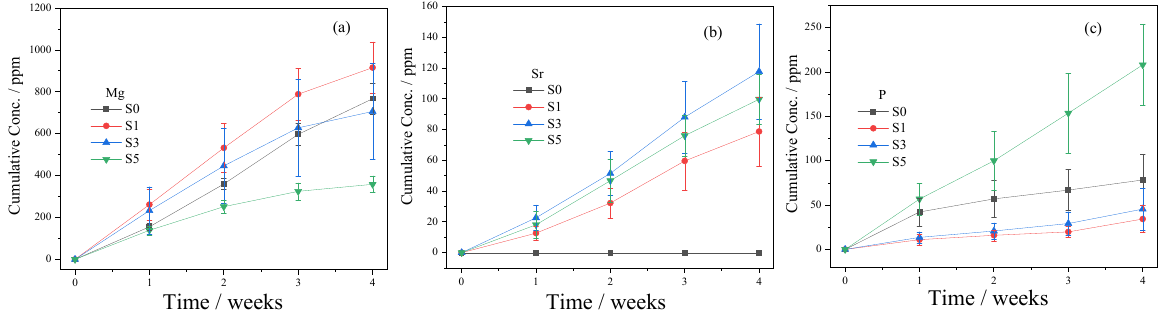
Figure 8. The accumulated concentration of Mg, Sr, and P elements ( a – c , respectively).